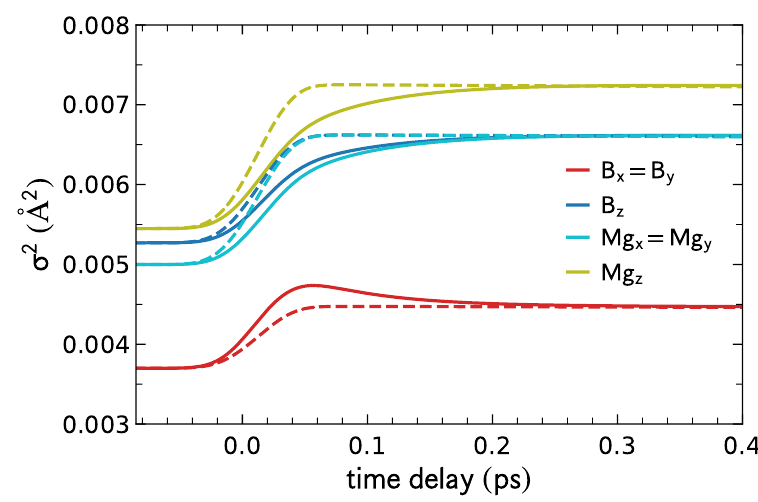
Figure 3: Time evolution of the mean square lattice displacements σ 2 for each atom and for different axis directions in the case of the hot-phonon scenario, described by Eqs. (2)-(4) (full lines). The corresponding results for the thermal phonon distribu- tion [ described by Eqs. (10)-(11) ] are shown with the dashed